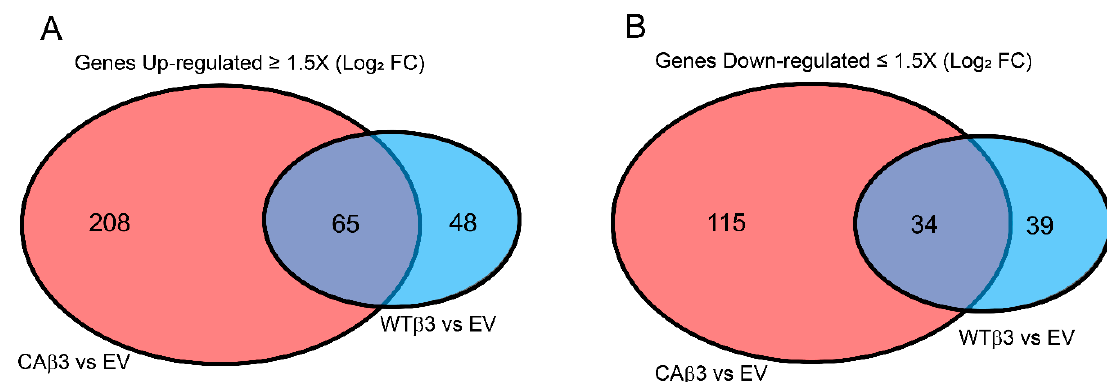
Figure 2. CA β 3 and WT β 3 cells have unique and shared sets of genes with altered expression. Venn diagram analysis was performed looking for differentially expressed genes that demonstrated a Log 2 FC ± 1.5 in CA β 3 or WT β 3 cells relative to control EV cells. The datasets from the CA β 3-EV and WT β 3-EV contrasts were analyzed using R statistical computing and graphics software. Shared and unique sets of genes that were upregulated ( A ) and downregulated ( B ) relative to EV cells were identified. The complete lists of unique and shared genes that met the FC cutoff are found in Tables S1–S6.